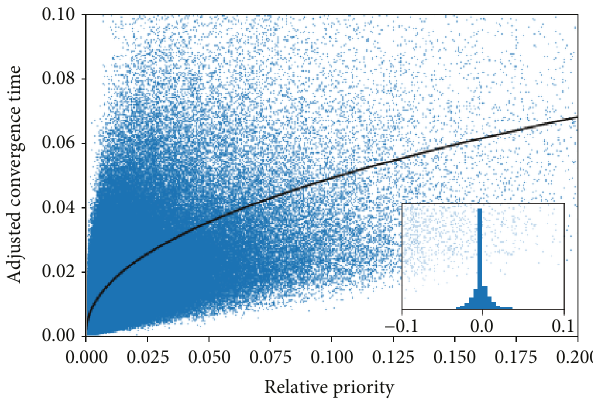
Figure 4: Expected convergence time from budgetary e ff ects for all country-modes pairs. The inset panel shows the deviations from the fi tted